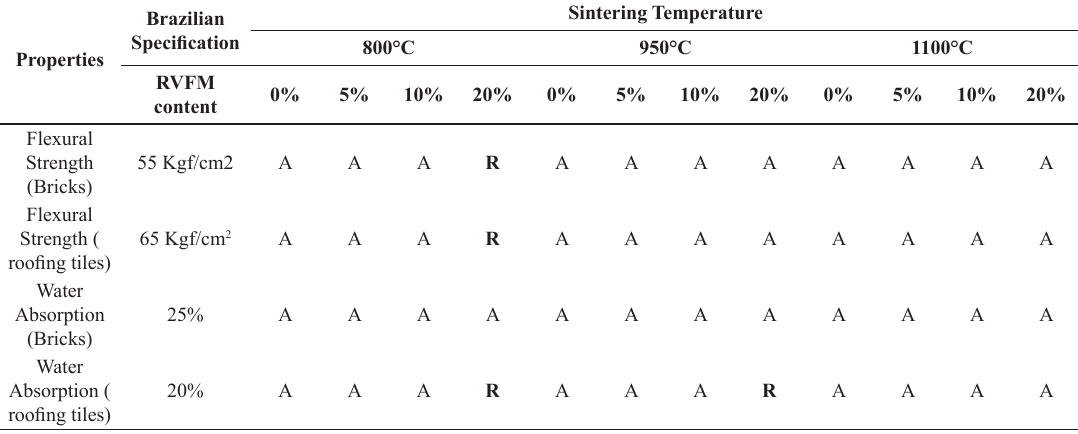
Table 6. Evaluation of the technical feasibility of the ceramics sintered at different temperatures and containing different amounts of RVFM, according to the Brazilian standard NBR 15310/2004 19 (“Ceramic Components - roofing tiles: Terminology, requirements and test methods”).